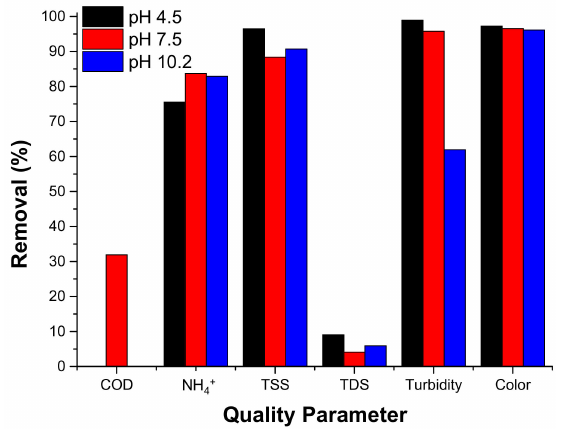
Figure 3. The effect of pH on the removal rate of COD, NH 4 + , TDS, TSS, turbidity, and color (current density = 64 mA/cm 2 ; inter-electrode distance= 1.5 cm; electrolysis time = 120 min; temperature = 20 ◦